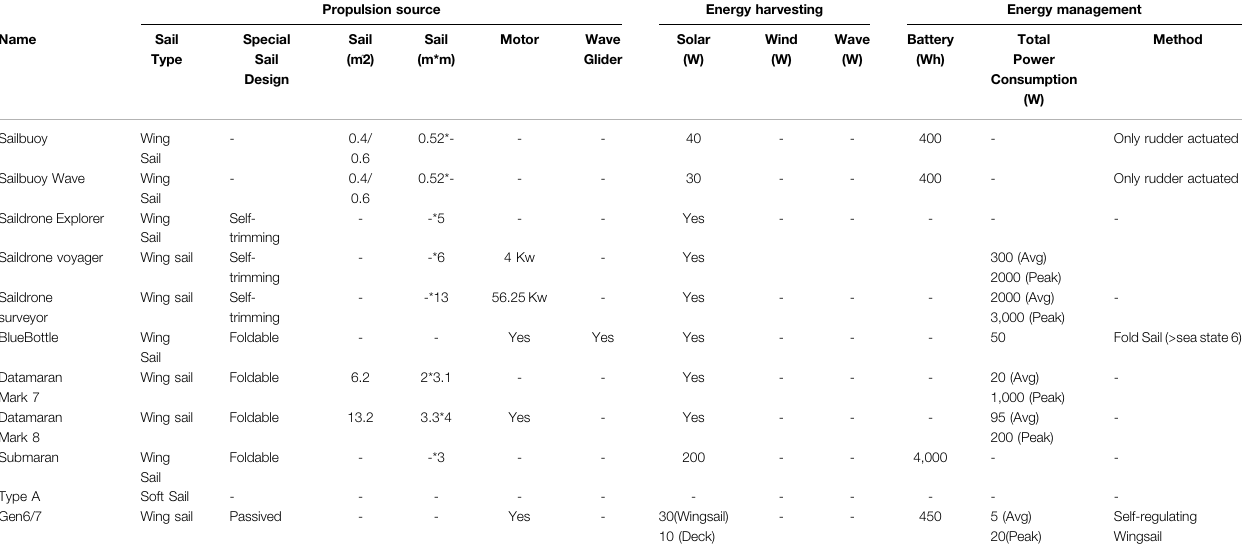
TABLE 4 | The sailboats con fi guration in different companies (Part